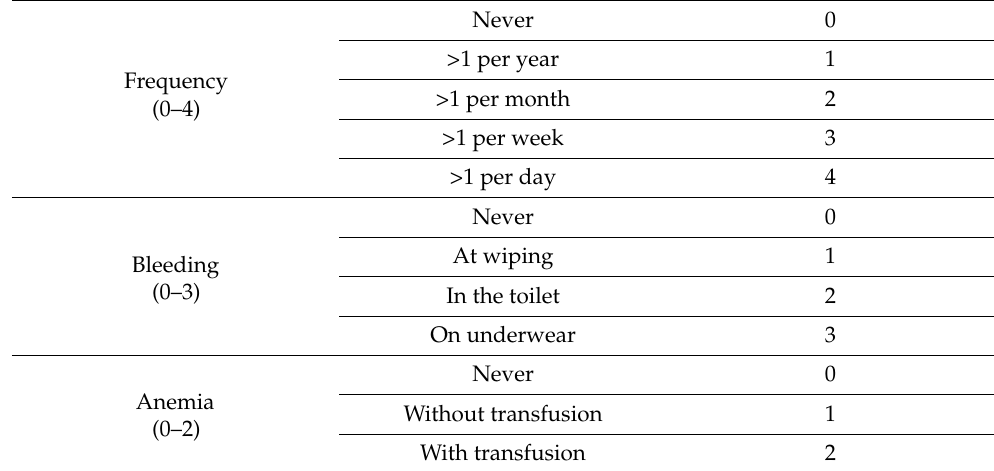
Table 2. French Bleeding Score.